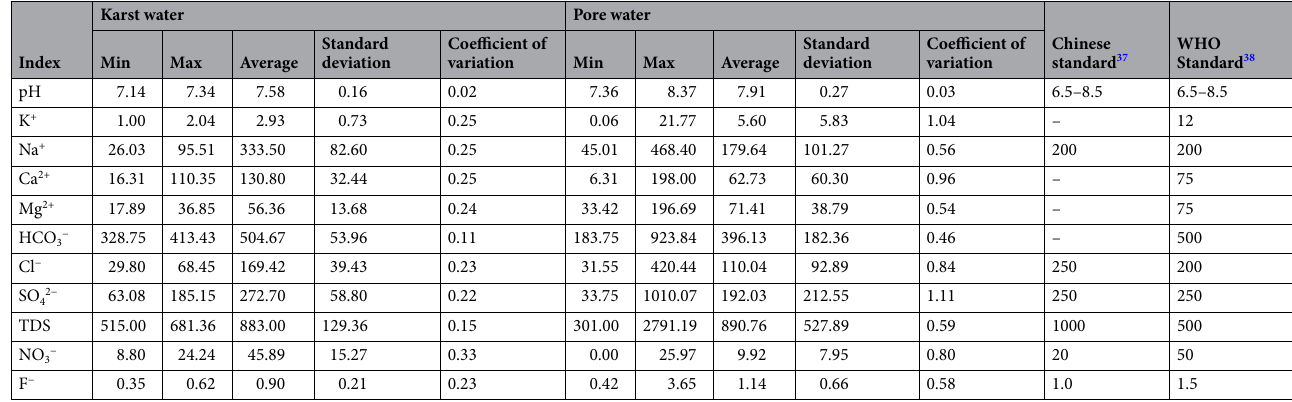
Table 2. Descriptive statistics for groundwater samples in Huaibei, China. Concentration of ions and TDS is